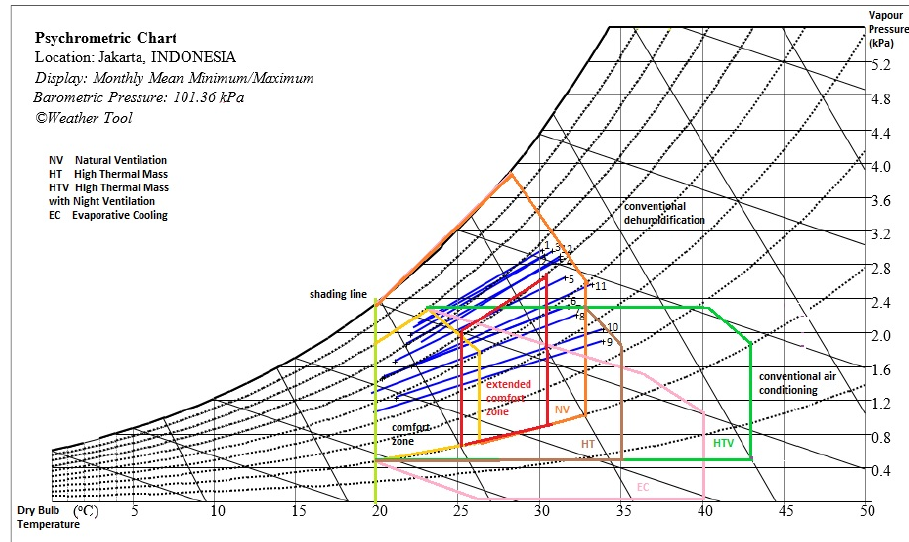
Figure 5. Givoni–Milne Bioclimatic chart of Jakarta.